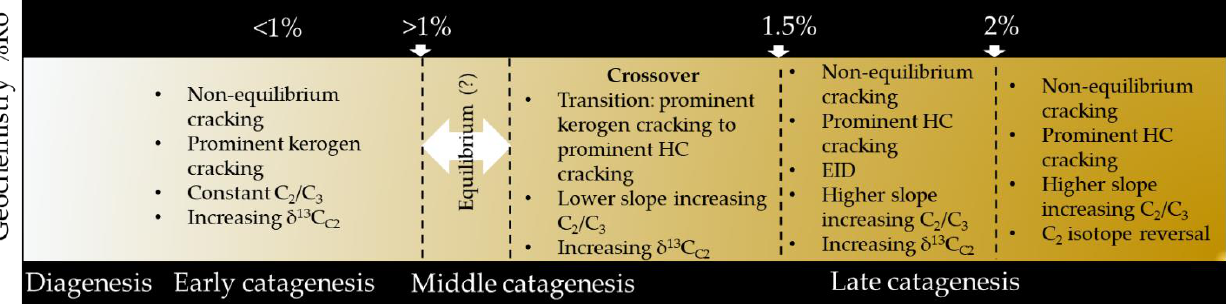
Figure 5. Diagram representing the geochemical characteristics to take into account when considering an equilibrium approach. After Thiagarajan et al. (2020) [13], Cesar et al. (2020) [12], and this study. “ Crossover ” stands for the suggested crossover between equilibrium and non-equilibrium conditions. The exact %Ro for the equilibrium (if established) remains unknown. EID: even isotopic distribution [12].